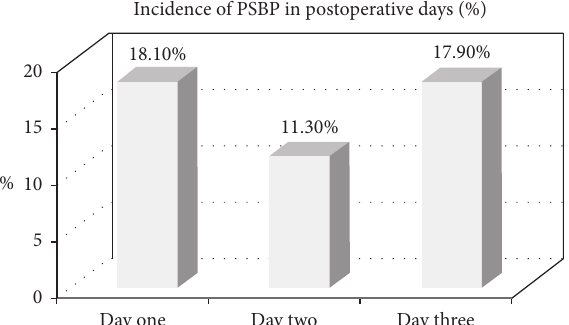
Figure 1: Prevalence of back pain on the three postoperative days at the University of Gondar Comprehensive and Specialized